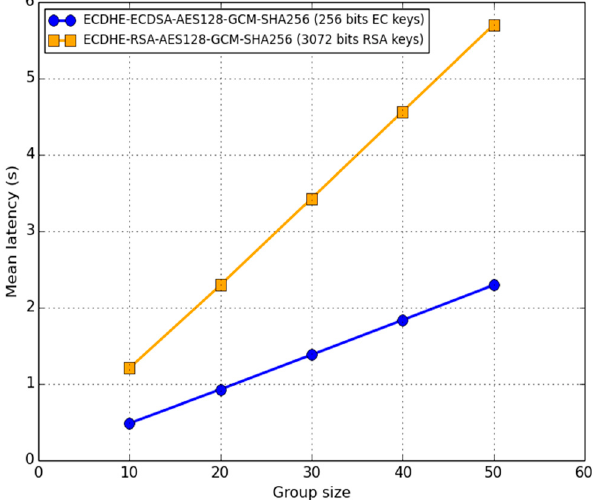
Figure 6. Latency (in seconds) for group key generation and distribution in a leave operation. Comparison experimental results as a function of the cardinality of set of remaining inverters and type / length of the keys: RSA vs. Elliptic Curve (EC) keys with 128 bits security level.